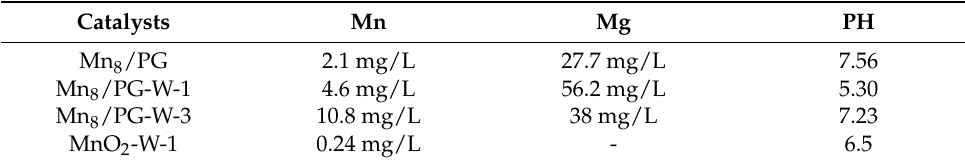
Table 3. Elements’ content in different water-washed solutions of